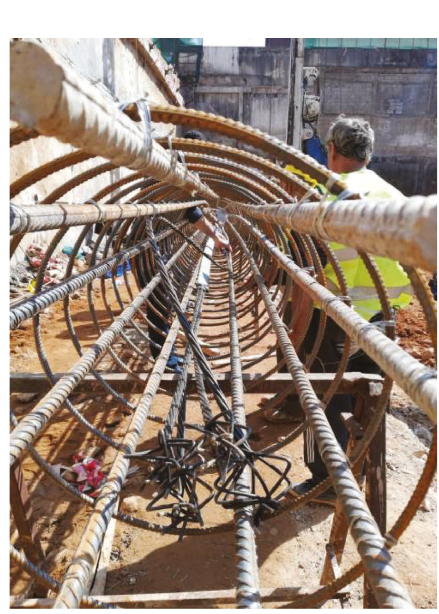
Figure 4: Steel cages with bulb-shaped strands. Figure 5: Pile hole